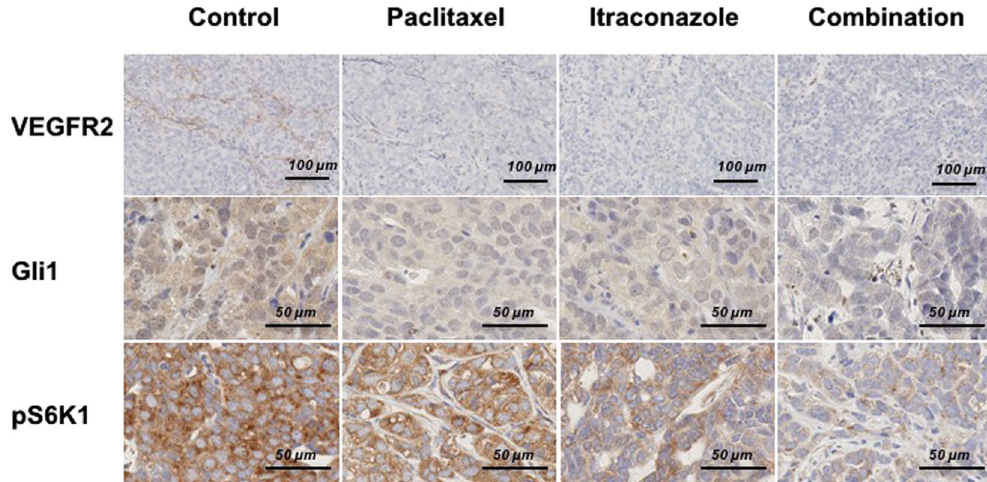
Figure 5. Itraconazole treatment decreases expression of key signaling molecules in the VEGFR2, hedgehog, and mTOR signaling pathways. Inhibition of VEGFR2, hedgehog, and mTOR pathways, as assessed by evaluating expression of VEGFR2, Gli1, and pS6K1 based on immunohistochemical staining of harvested tumor tissues, was significantly lower in the combination group than the paclitaxel alone group. All photographs were taken at a magnification of